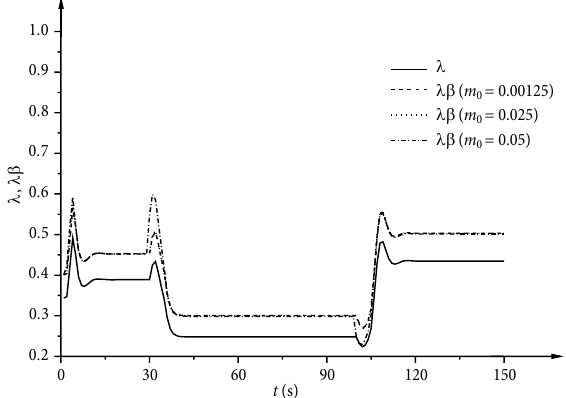
Fig. 7. Profiles of the distance headways between the lead and following vehicles in Ex. 7